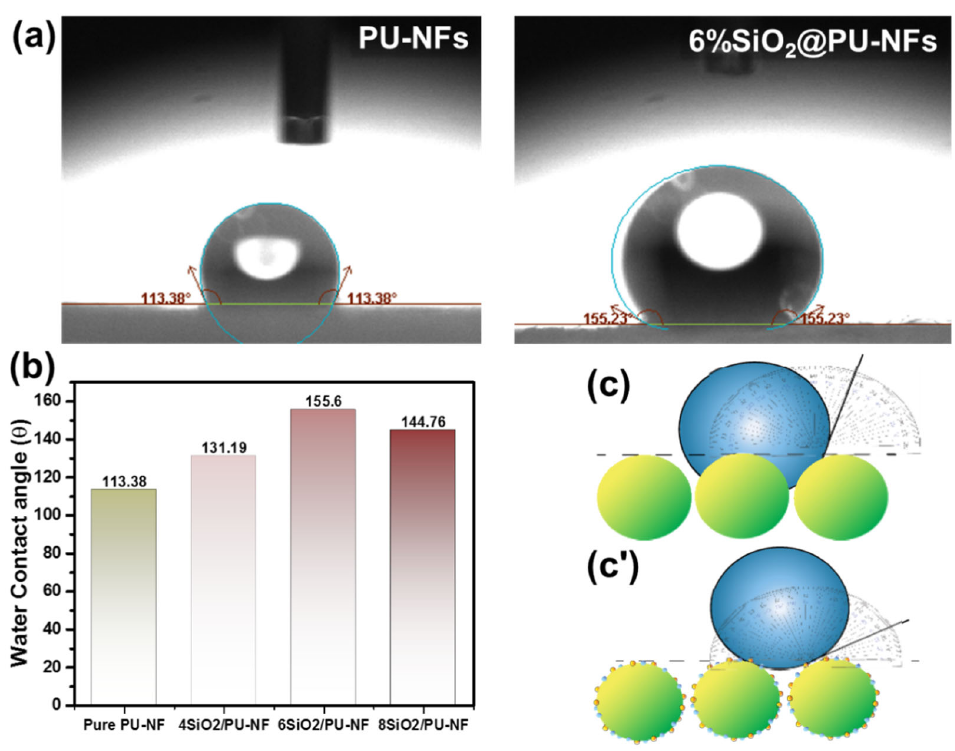
Figure 5. ( a ) WCA of pure PU − NFs and composite SiO 2 @PU-NFs; ( b ) impact of di ff erent SiO 2 -NPs concentration on the WCA of SiO 2 @PU-NFs; ( c , c ′ ) schematic illustration of hydrophobic PU − NFs concentration on the WCA of SiO 2 @PU-NFs; ( c , c (cid:48) ) schematic illustration of hydrophobic PU-NFs and and superhydrophobic and superhydrophobic composite SiO 2 @PU − NFs membrane. superhydrophobic and superhydrophobic composite SiO 2 @PU-NFs